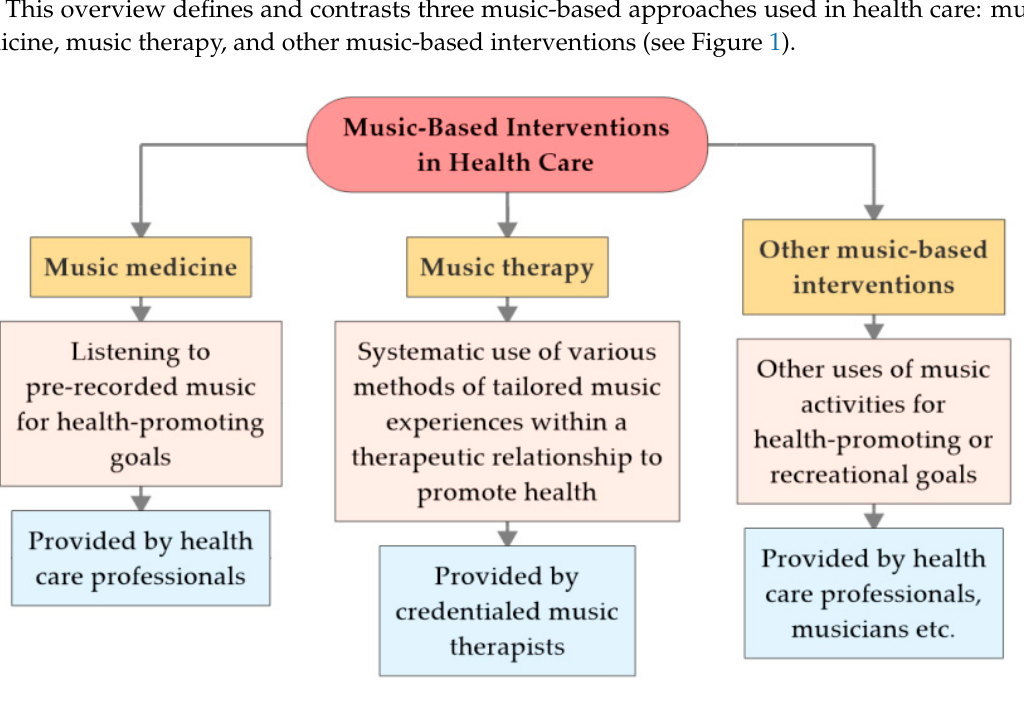
Figure 1. Types of music-based interventions in health care.